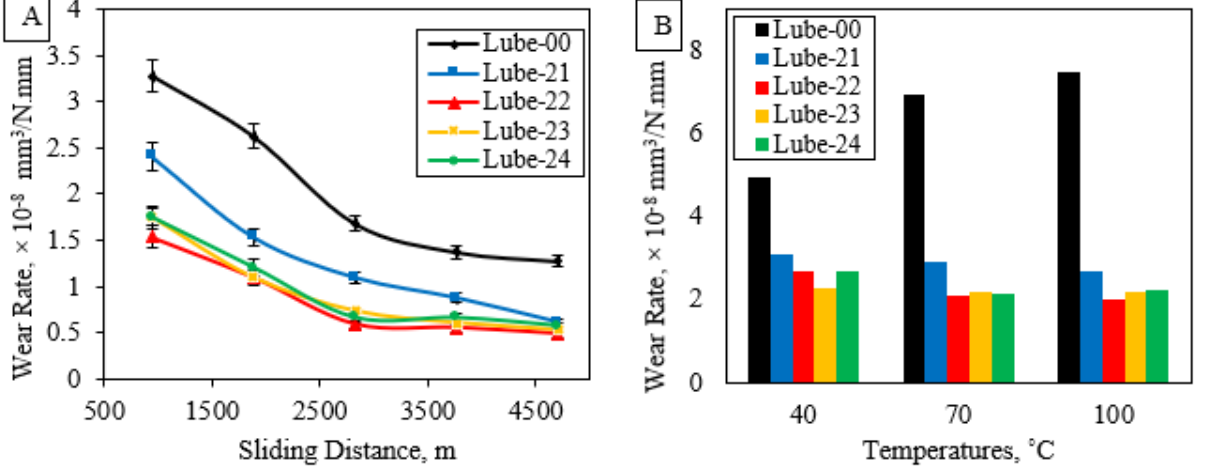
Figure 6. Wear rate of hybrid nano lubricant samples with various loading contents of Al 2 O 3 NPs and 1.0 wt.% MWCNTs ( A ) at different speeds and ( B ) at different temperatures.